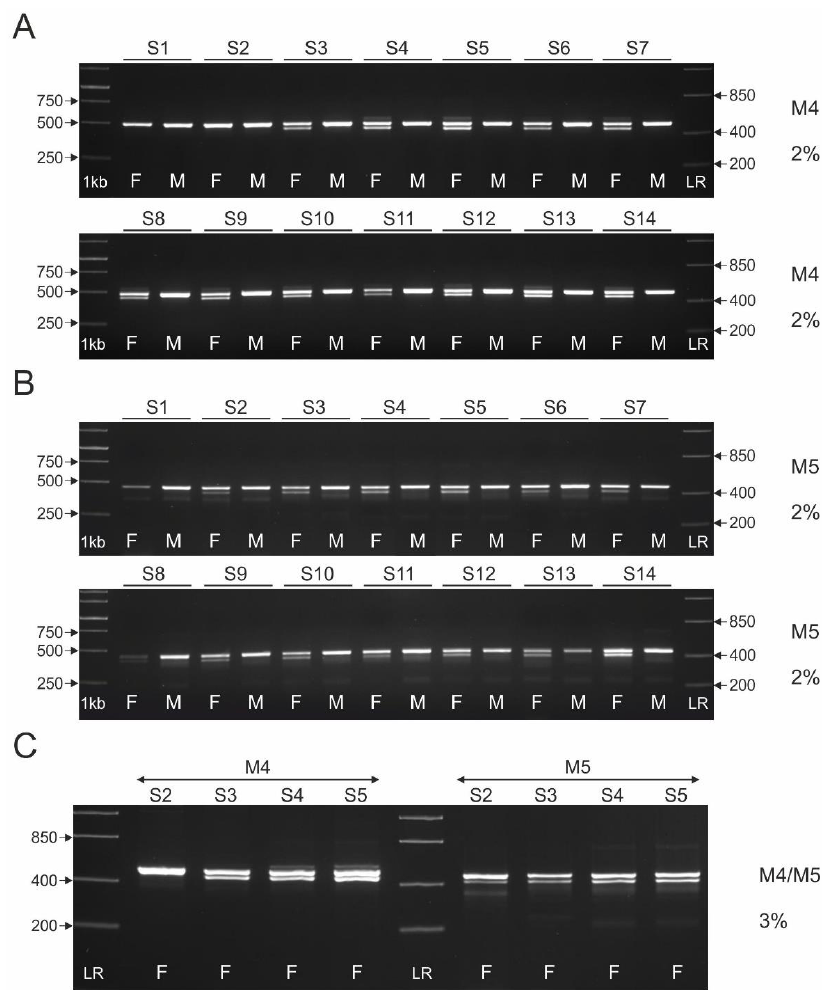
Figure 4. Patterns of the PCR products representing M4 ( A ) and M5 ( B ) markers obtained for male (M) and female (F) individuals of fourteen turaco species (S1 – S14, see Table 1). The amplicons were resolved in 2% agarose gel. The female amplicons resolved in 3% agarose gel (S2 – S5) are shown in ( C ). Lane 1 kb — GeneRuler 1 kb DNA Ladder (Thermo Scientific). Lane LR — FastRuler Low Range DNA Ladder (Thermo Scientific).